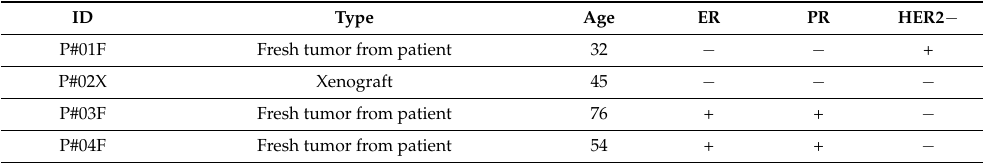
Table 1. BCa patient sample summary (all